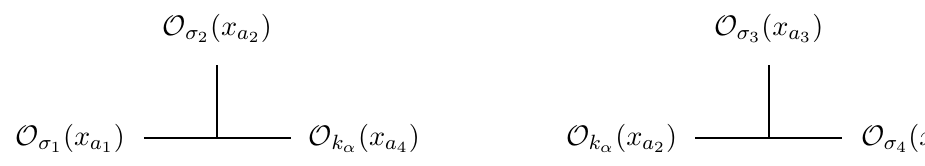
( x ) O ( x ) ∼ a 1 σ 2 a 2 1